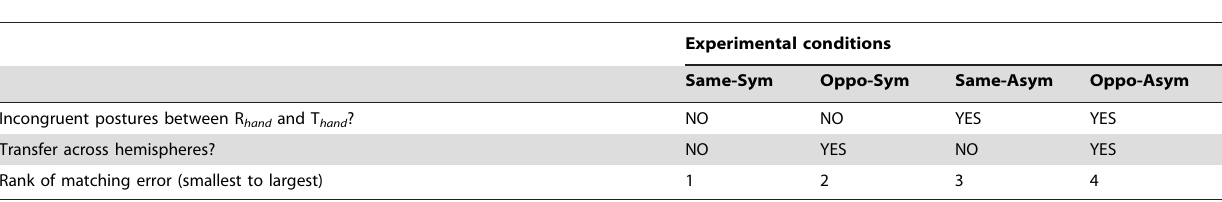
Table 1. Task differences across experimental conditions and rank of matching